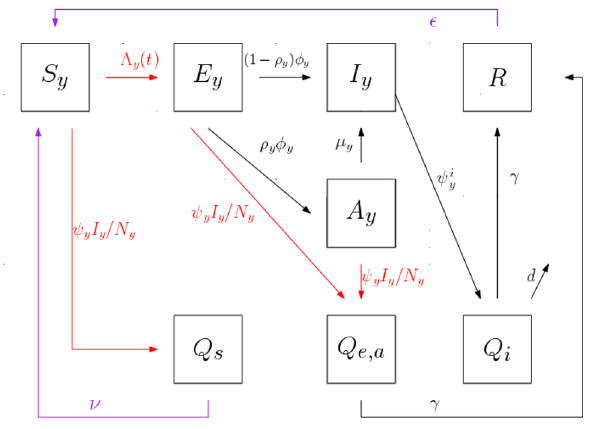
Figure 3. Schematics showing the flow between Susceptible ( S y ), Latent ( E y ), Infectious ( I y ), Asymptomatic ( A y ), Recovered ( R ) and Quarantined ( Q i , Q e , a , Q s ) individuals, for each location y ∈ { h , w , c , o } , such that h represents home, w work, c educational facilities, and o other locations for example for leisure activities. The read arrows represent rates that depend upon a contact with infectious individuals I y . The dashed-dotted purple arrow just holds when y = h . See Table 3 for the description of the